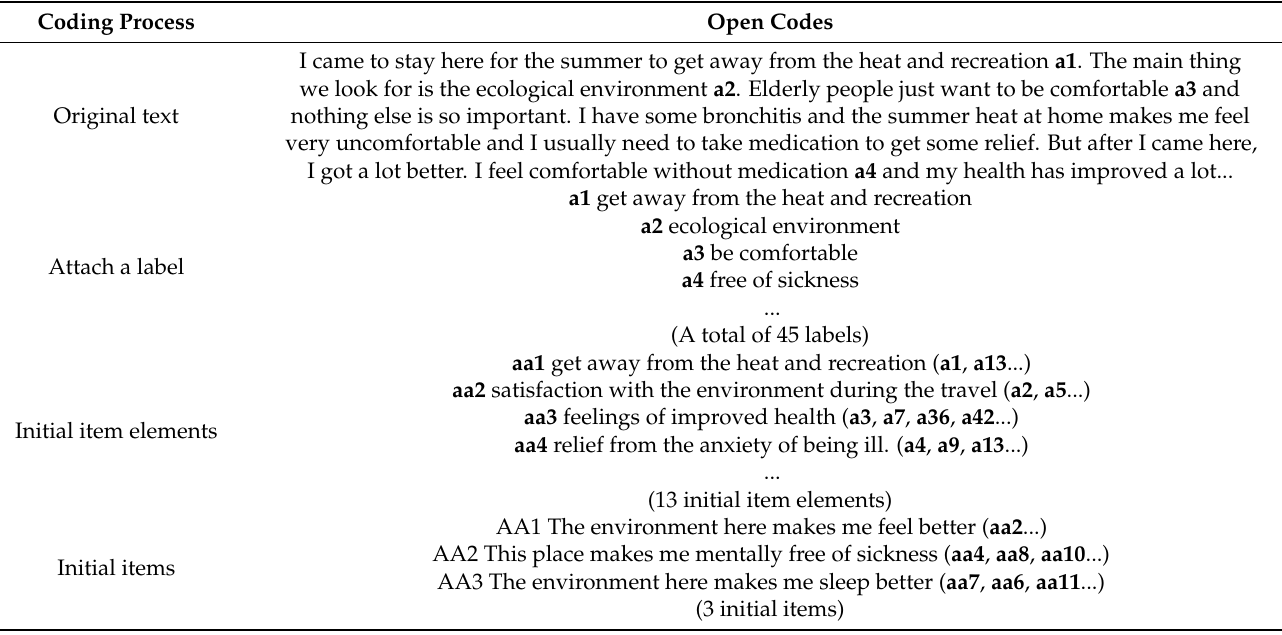
Table A1. Example of open